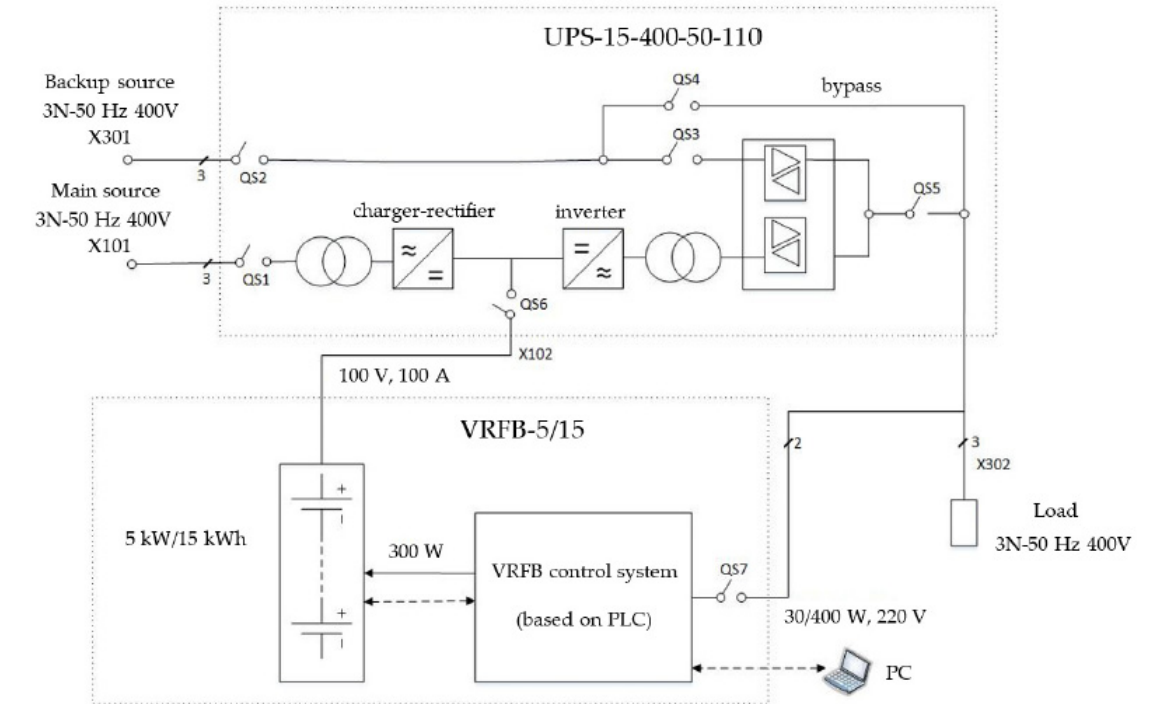
Figure 7. Block diagram of the UPS system based on 10 kW/30 kWh vanadium redox flow batteries [21].